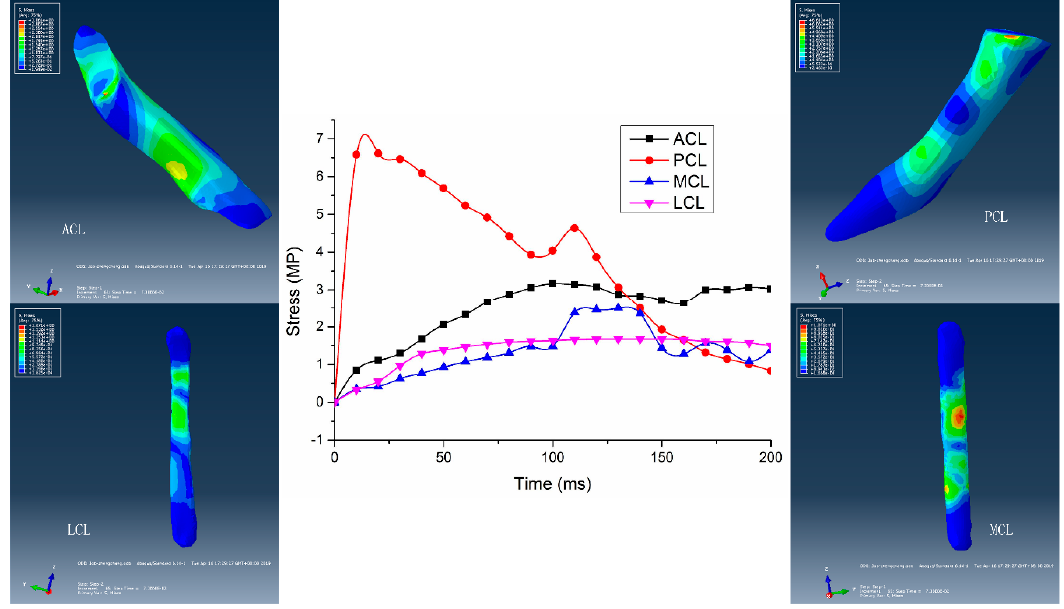
Figure 8. Stress distribution and stress–time curve of the ligaments in neutral landing.